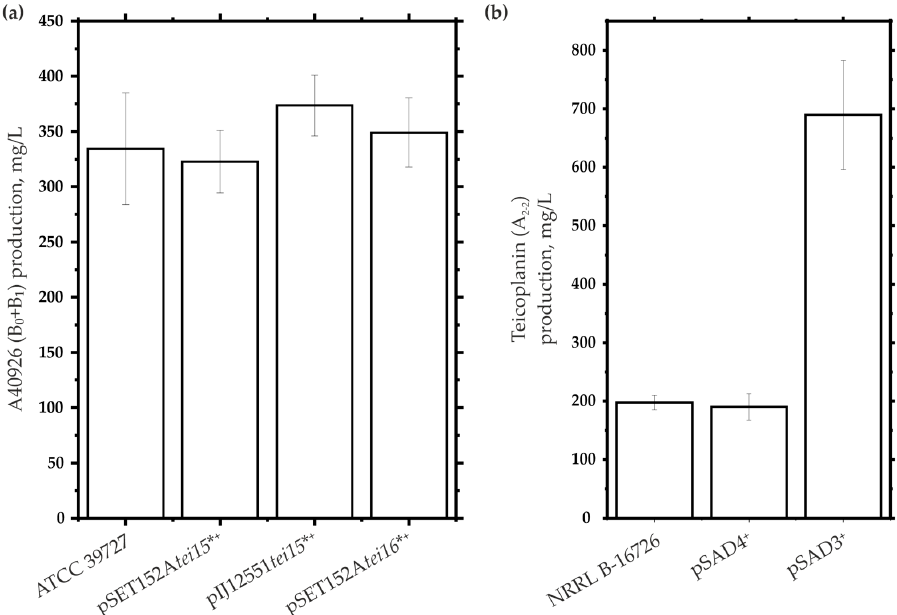
Figure 6. GPA production in N. gerenzanensis ( a ) and A. t eichomyceticus ( b ) strains, expressing heterologous CSRGs. ( a ) A40926 production levels in FM2 medium by N. gerenzanensis ATCC 39727, N. gerenzanensis pSET152 tei15* + , N. gerenzanensis pIJ12551 tei15* + , and N. gerenzanensis pSET152 tei16* + after 144 h growth; A40926 was extracted and measured as described in Materials and Methods. ( b ) Teicoplanin production in TM1 medium by A. teichomyceticus NRRL B-16726, A. teichomyceticus pSAD4 + , and A. teichomyceticus pSAD3 + after 96 h growth. Teicoplanin was extracted and measured as described in Materials and Methods. Data represent mean values of three independent experiments ± 2SD.